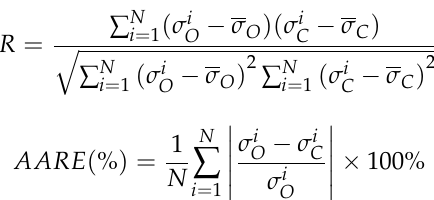
Figure 12. Correlation between the predicted and the experimental values of flow stress by: ( a ) SA, ( b ) BP–ANN, and ( c ) ANN–GA models.